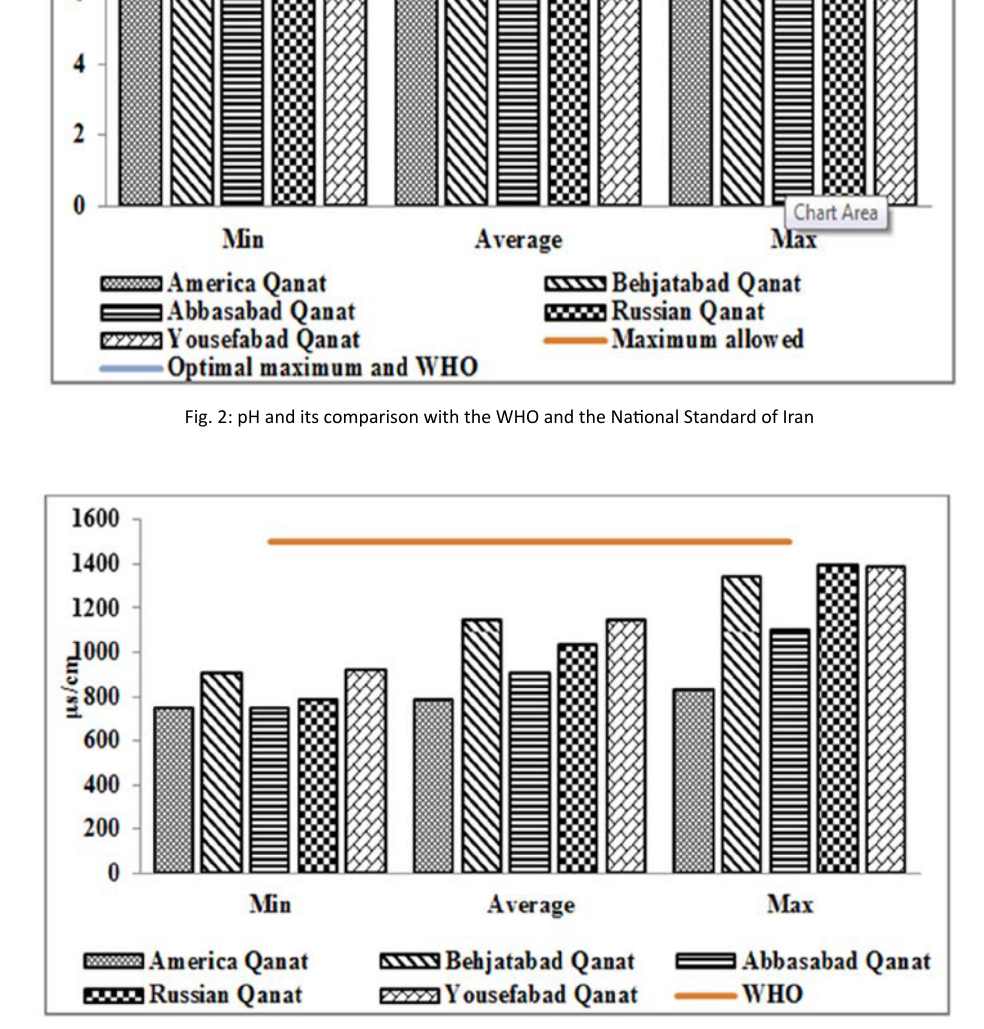
Fig. 3: EC level and its comparison with the WHO and the National Standard of Iran